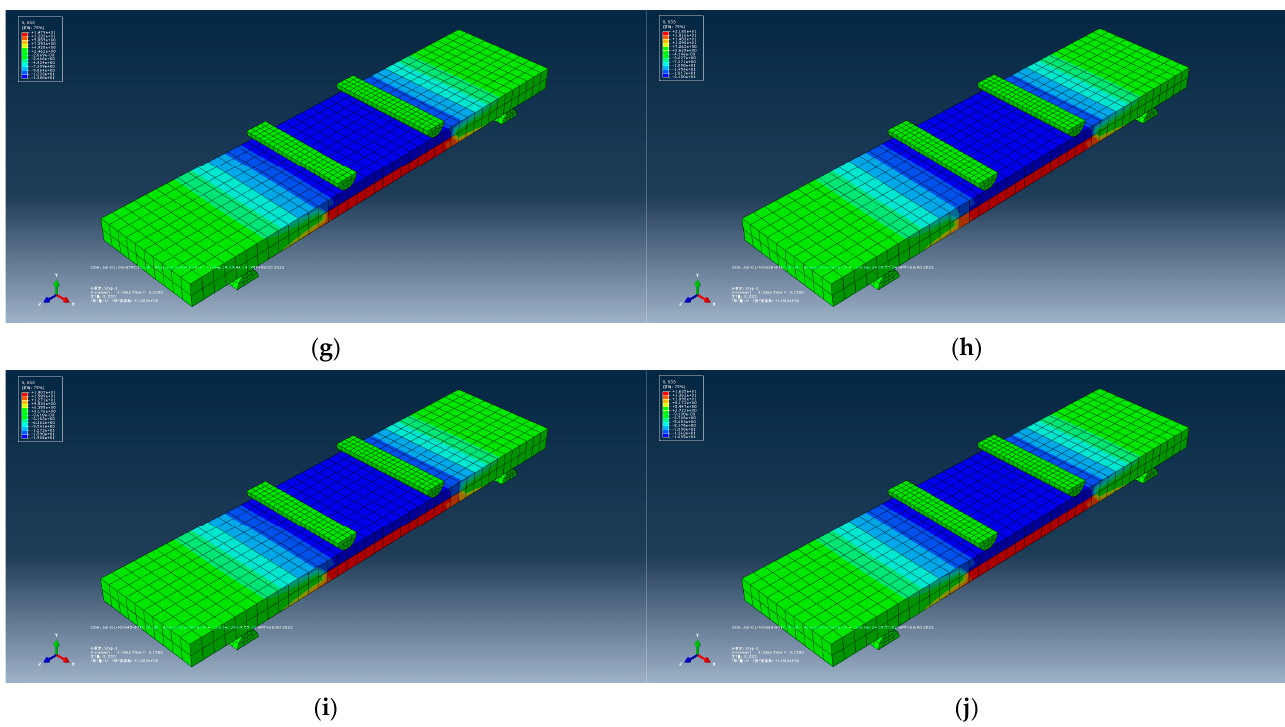
Figure 13. S33 Mises stress clouds of BTRC specimens. ( a ) SL-OG-BTRC40; ( b ) DL-OG-BTRC40; ( c ) DL-NOG30-BTRC40; ( d ) DL-NOG45-BTRC40; ( e ) DL-NOG60-BTRC40; ( f ) SL-OG-BTRC20; ( g ) DL-OG-BTRC20; ( h ) DL-NOG30-BTRC20; ( i ) DL-NOG45-BTRC20; ( j ) DL-NOG60-BTRC40. Table 6. Error analysis between the simulated value and the experimental value of S33. Simulated Experimental Relative Group Value/MPa Value/MPa Deviation/% SL-OG-BTRC20 18.50 SL-OG-BTRC40 DL-OG-BTRC20 DL-OG-BTRC40